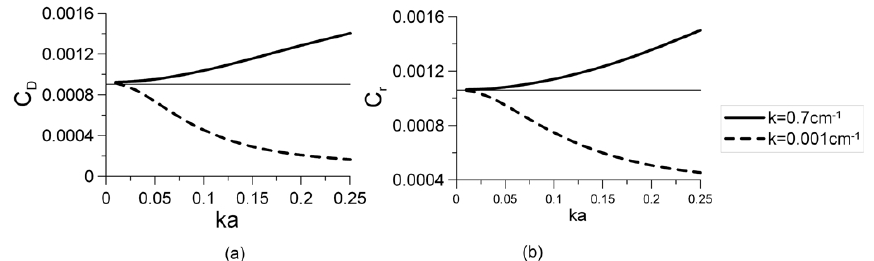
Fig. 10. Dependencies of the coefficients of aerodynamic resistance (a) and mass exchange (b) on the steepness of the wave for u ∗ = 10cms − 1